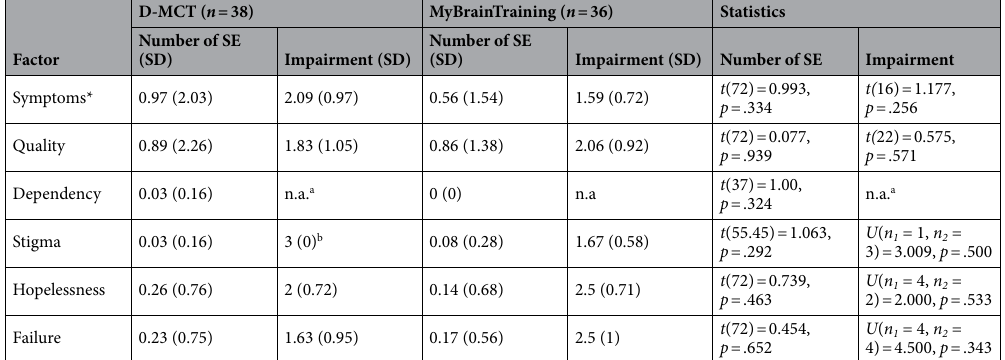
Table 5. Mean number of side effects (SE) and rated impairment rates (standard deviations in brackets) associated with the study intervention. If the assumption of equal variances was violated, the Welch’s t-test was used. For the smaller subgroups, the Mann–Whitney U test was used ( n 1 = D-MCT, n 2 = MyBrainTraining). n.a. = not available. *The subscale “symptoms” of the Negative Effects Questionnaire (NEQ) was missing one item. a Only 1 patient rated dependency, but they did not provide a score for impairment. b Only 1 patient rated